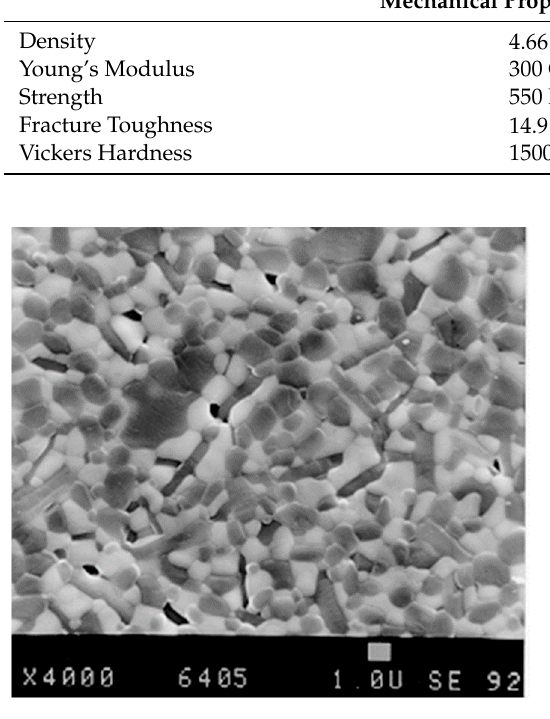
Figure 33. Microstructure of a ceria stabilized alumina matrix composite.